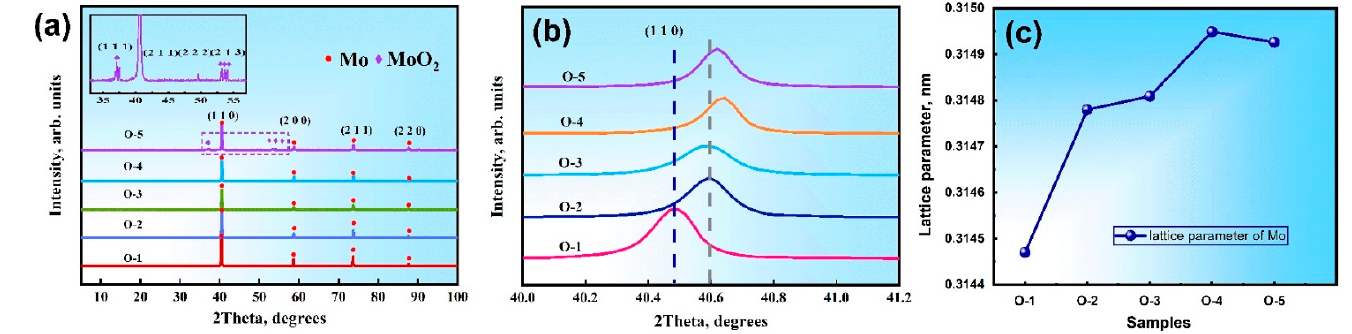
Figure 5. XRD patterns of Mo samples. ( a ) The overall XRD curves of Mo. ( b ) The enlarged (110) peaks show the shift of the peaks. ( c ) The lattice parameters of Mo.